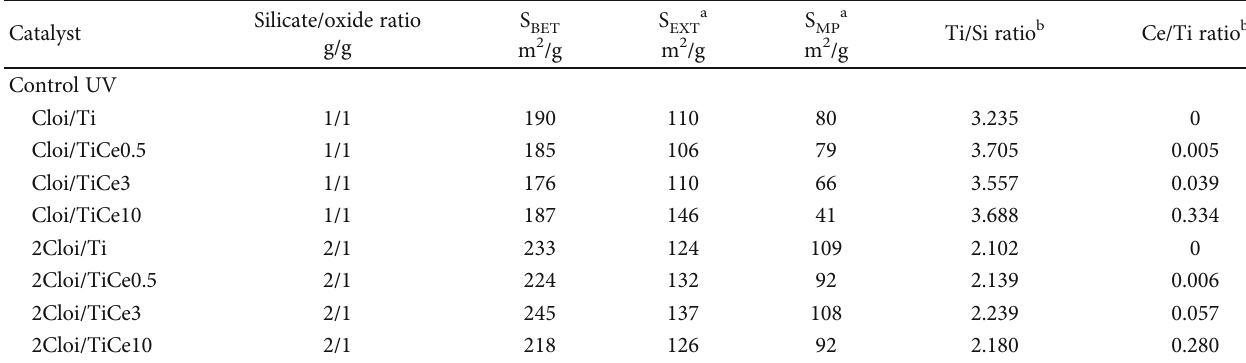
Figure 3: Shows the physicochemical properties: (a) Surface area, S-BET, external surface S-EXT, and internal surface S-MP; (b) Ti/Si and Ce/Ti were obtained by ICP. Table 1: Physicochemical properties of the